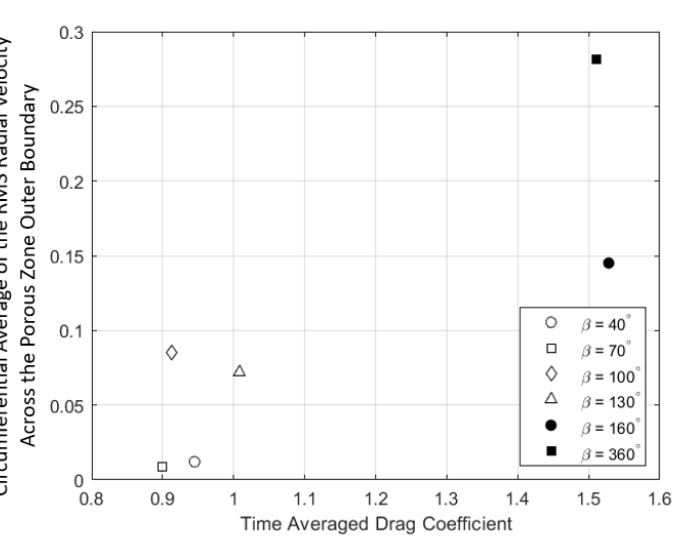
Figure 8. Circumferential average of the RMS radial velocity across the porous zone outer boundary for varying coating angle β at Re = 4.2 × 10 4 , constant thickness t / D = 14.3% and a porosity of 20 PPI.